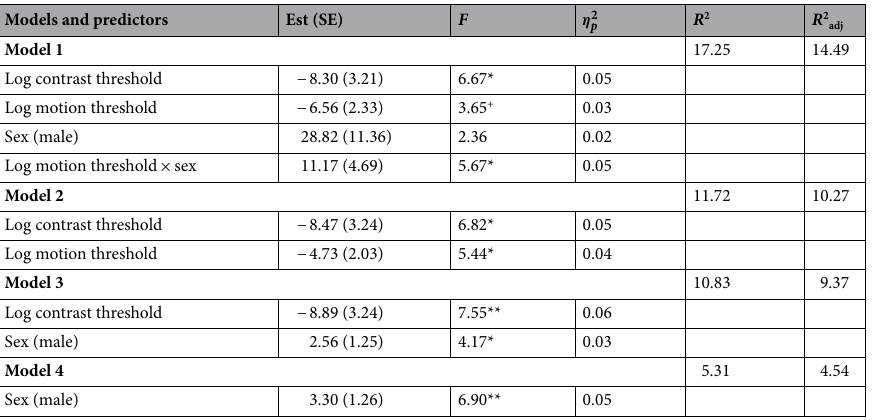
Table 1. Comparisons among regression models predicting mental rotation scores. Parameter estimate summaries for a model predicting mental rotation from sex, log contrast thresholds, log motion thresholds, and a sex by log motion threshold interaction (Model 1), a model including vision measures alone (Model 2), a model including log contrast thresholds and sex (Model 3), and a model including sex alone (Model 4). + p < 0.1, *p < 0.05, **p <